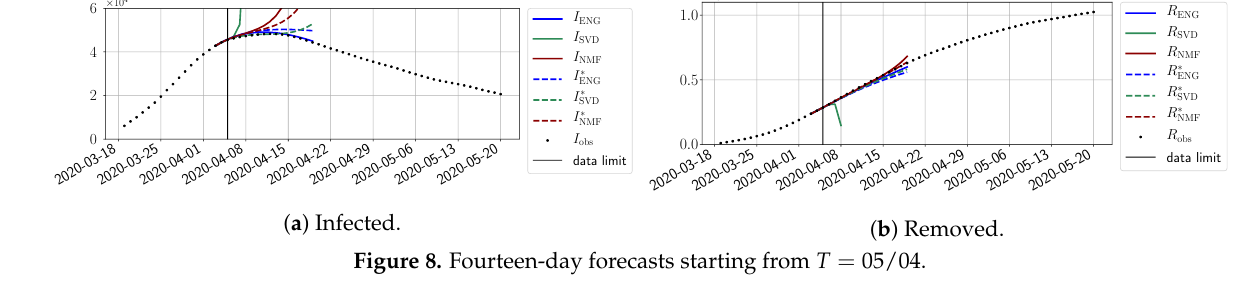
Figure 8. Fourteen-day forecasts starting from T = 05/04.